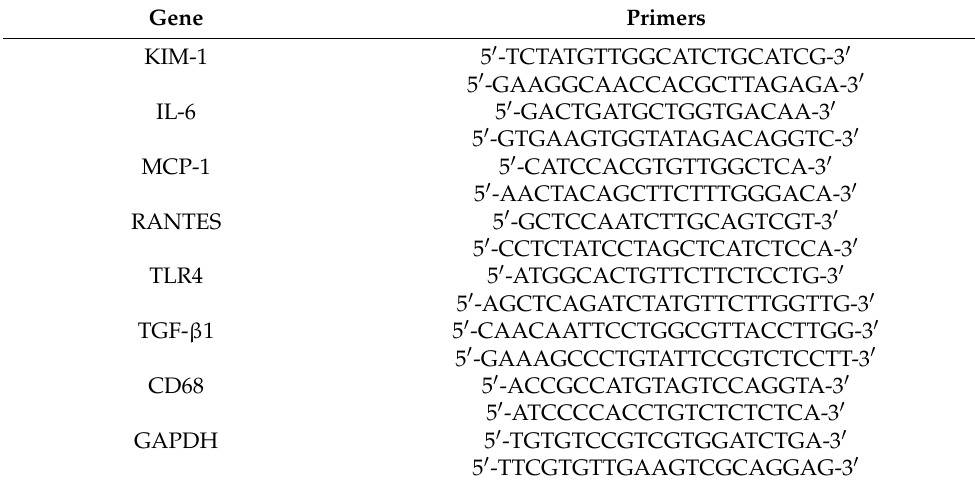
Table 1. Primer sequences used for real-time PCR